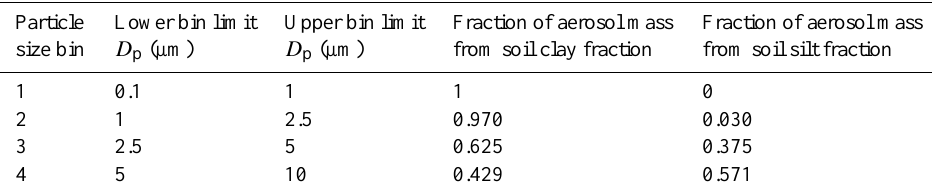
Table 2a. The fraction of dust aerosol mass contributed by the soil clay and silt fractions for each of the four particle size bins for the bulk aerosol scheme in CAM4 from work by Kok (2011). Particle Lower bin limit Upper bin limit Fraction of aerosol mass Fraction of aerosol mass size bin D p (µm) D p (µm) from soil clay fraction from soil silt